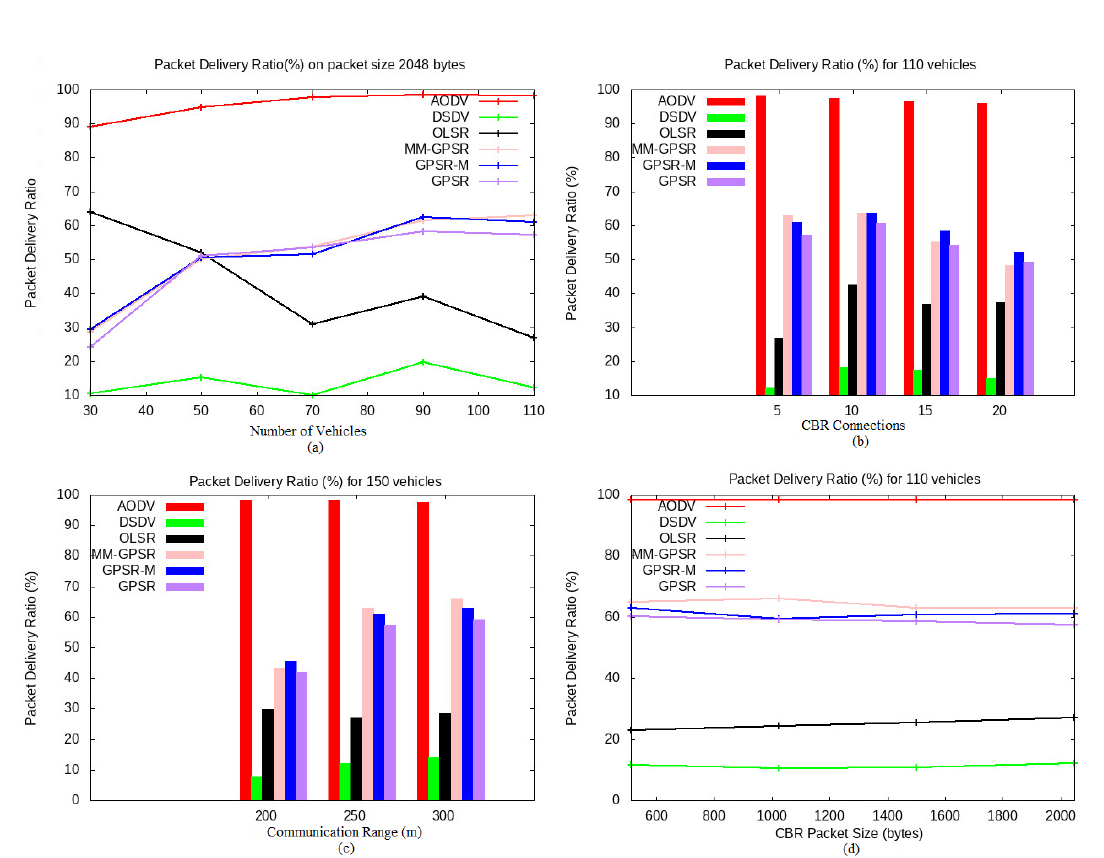
Figure 4. PDR results on various network